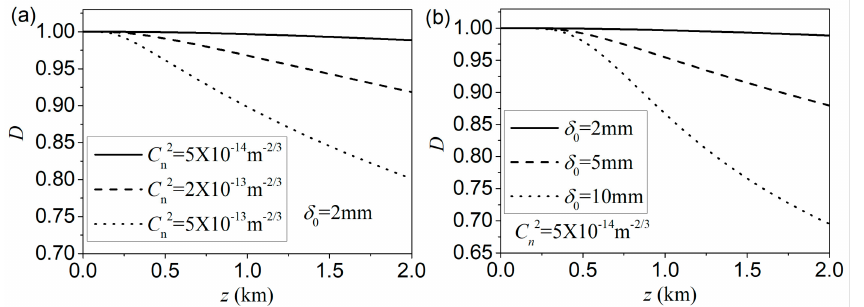
Figure 6. The variation of parameter D with propagation distance for ( a ) different structure constants and ( b ) different initial coherence